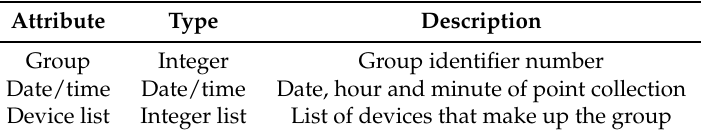
Table 9. Algorithm 2 output structure (detection of groups).